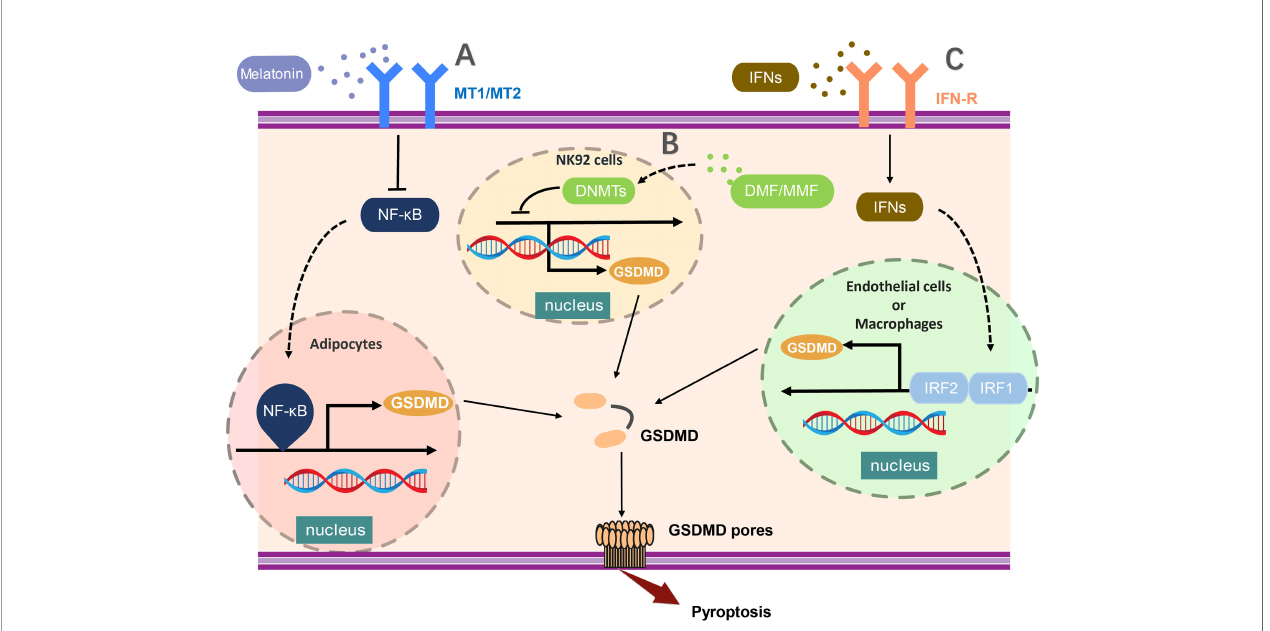
FIGURE 1 | The transcriptional regulation of GSDMD expression. (A) NF- k B activation critically promotes the transcription of GSDMD in adipocytes and (B) the hypermethylation of the promoter region mediated by DNMT (DNA methyltransferases) results in the reduced expression of GSDMD in NK92 cells. (C) In endothelial cells or macrophages, GSDMD expression was profoundly enhanced by activation of both IRF1 and IRF2. The transcription of GSDMD could be regulated by multiple molecules, such as melatonin, DMF, and MMF. MT1/MT2, Melatonin receptor; NF- k B,nuclear factor k B; DNMT, DNA methyltransferases; DMF, dimethylfumarate; MMF, monomethylfumarate; IFNs, interferon; IRF1/2, Interferon Regulatory Factor